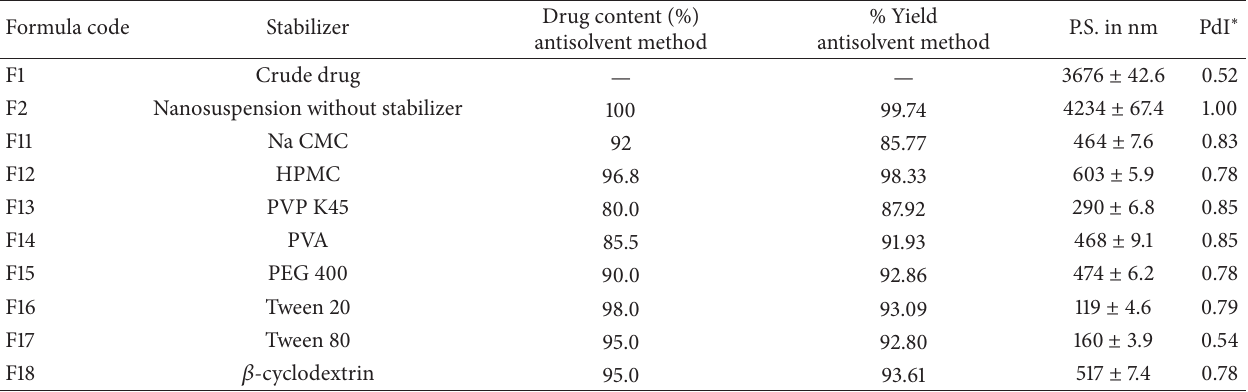
Table 2: Drug content, percentage yield, particle Size (P.S.), and size distribution of nanosuspensions prepared by antisolvent method. Formula